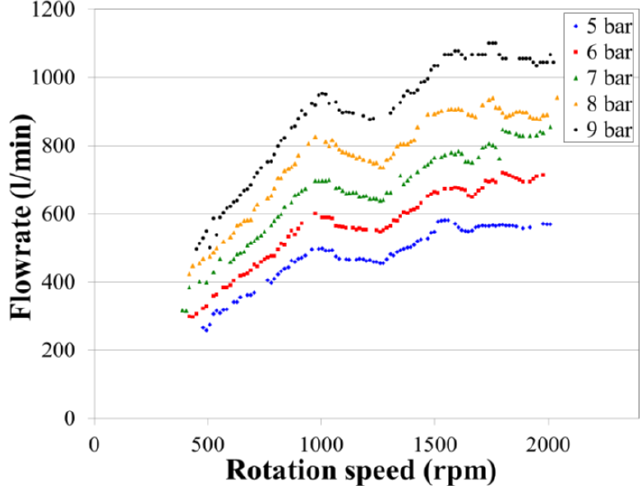
Figure 12. The acquired flow rate of the compressed air engine at different rotation speeds and supplied air pressures.